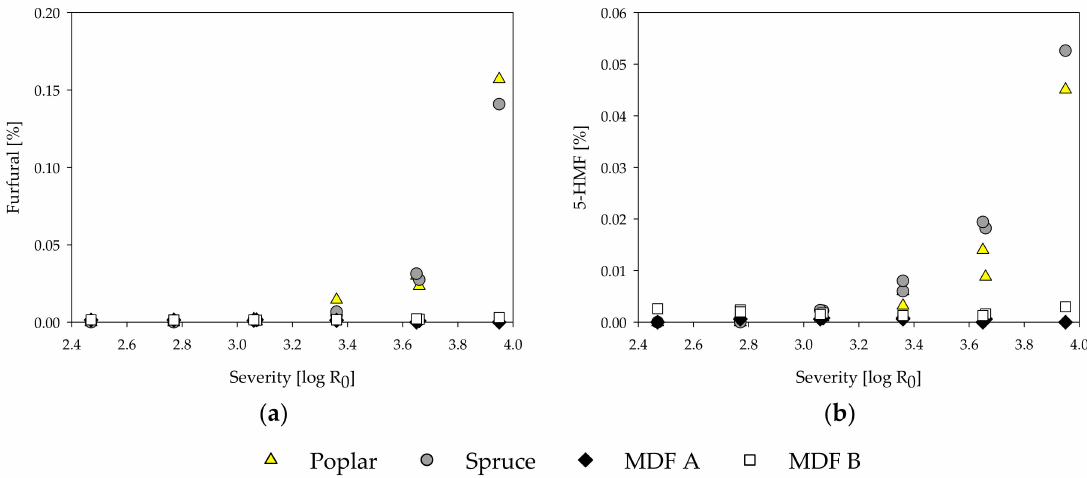
Figure 5. Influence of treatment severity on furfural ( a ) and 5-hydroxymethylfurfural (5-HMF) ( b ) content of steam-refining extracts of poplar, spruce, and the MDF samples.